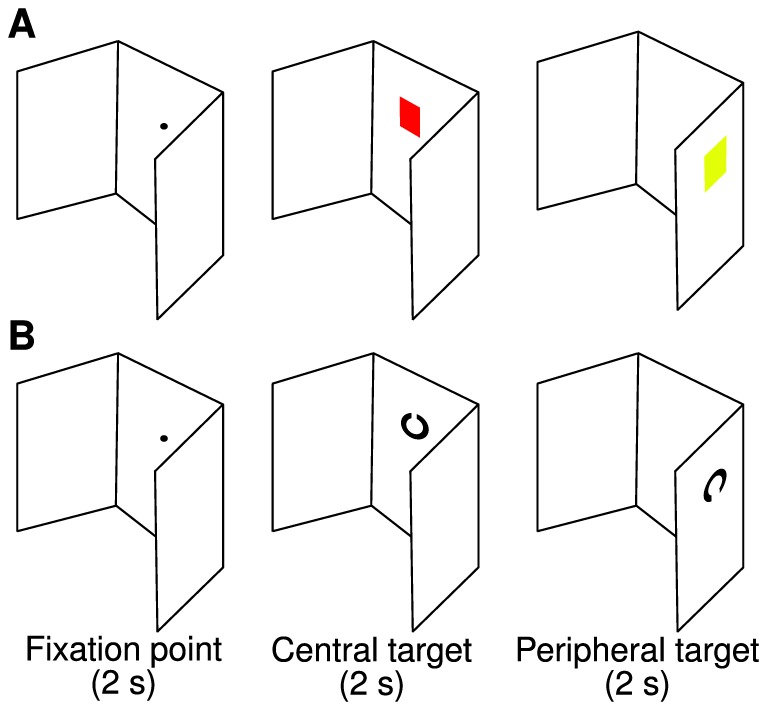
Visual peripheral recognition task with 2 exemplary trials: the color (A) and Landolt (B) tasks.Stimulus duration is stated below the figures. Reprinted from www.jemr.org
[49] under a CC BY license, with permission from the Journal of Eye Movement Research, original copyright 2012.